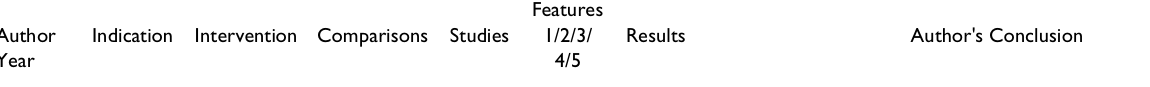
Table 3: Systematic reviews of clinical trials of herbal medicines (at least 2 reviews per herb)